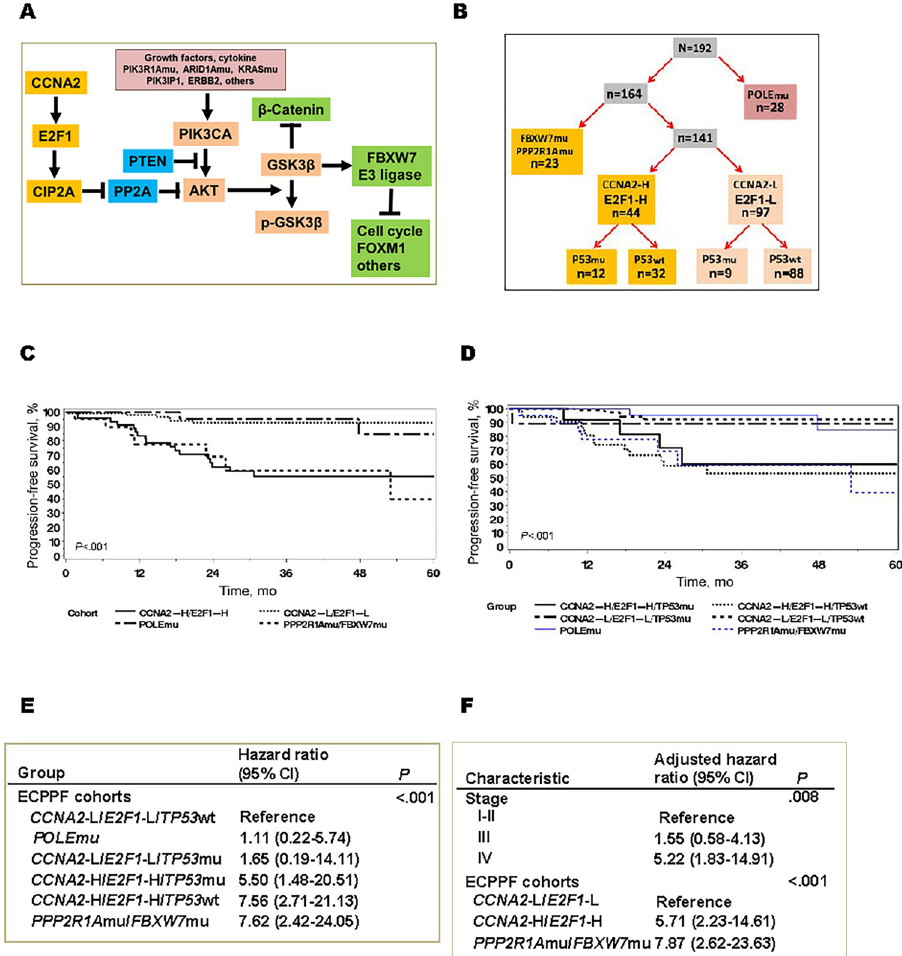
Fig 1. Molecular profile and clinical outcomes. A, Integrated schematic showing the CCNA2-E2F1-CIP2A axis and PI3K-AKT-GSK3 β -FBW7 pathway. B, ECPPF stratification was used to identify distinct molecular subgroups from a cohort of 192 patients with endometrioid endometrial cancer. The stratification scheme considers POLE mutations (-mu), PPP2R1A mu, FBXW7 mu, CCNA2 -H/ E2F1 -H, and CCNA2 -L/ E2F1 -L; the latter 2 are stratified by TP53 status ( TP53 mu and TP53 wild type [-wt]). Suffixes -H and -L denote high or low gene expression levels, respectively. C, Progression-free survival rates for 4 primary ECPPF molecular cohorts. D, Progression-free survival for ECPPF molecular cohorts with CCNA2 -H/ E2F1 -H and CCNA2 -L/ E2F1 -L, stratified by TP53 mu and TP53 wt. E, Cox proportional hazards model with hazard ratios for 6 ECPPF molecular cohorts, using CCNA2 -L/ E2F1 -L/ TP53 wtas the reference. F, A stepwise multivariate analysis considering competing variables with P < .20 in the univariate analysis (age, grade, depth of myometrial invasion, stage, high microsatellite instability, no specific molecular profile, TP53 mu, homologous recombination repair mutations, CTNNB1 mu, KRAS mu, ARID1A mu, PIK3CA mu, PTEN mu, PIK3R1 mu, CIP2A expression, and ECPPF